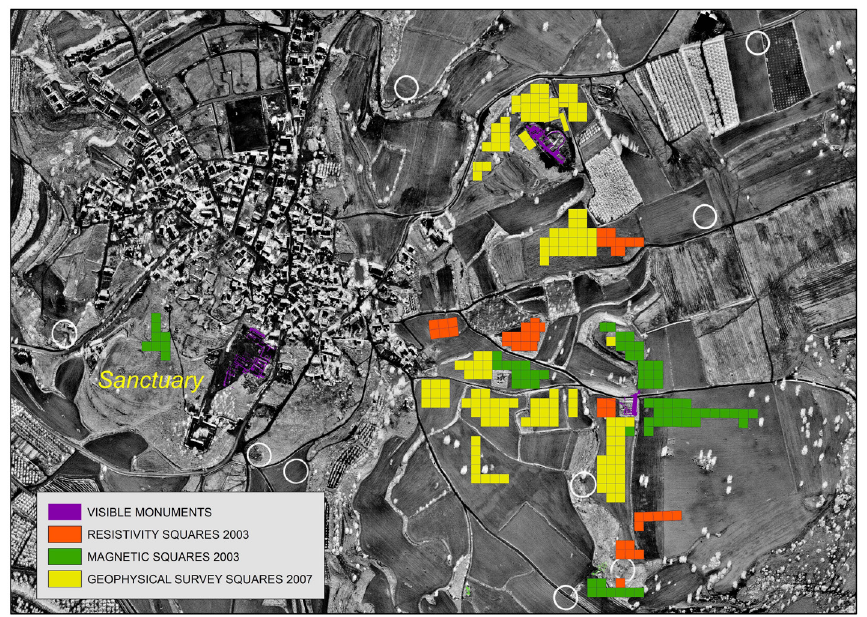
Figure 9. Parcels covered by the geophysical surveys of 2003 and 2007. Drafted by A. Sarris